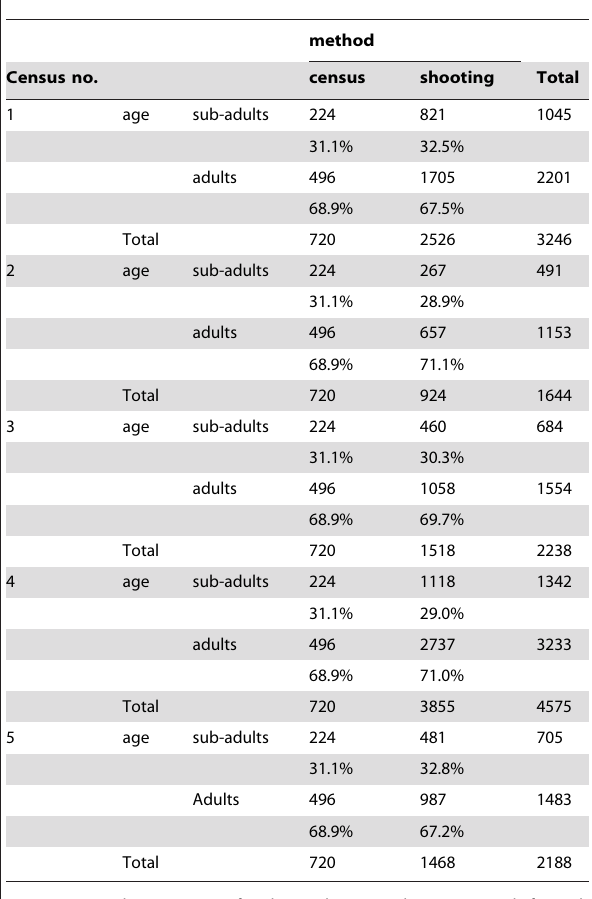
Table 2. Results of the exhaustive post-mortem examination of culled gulls (N =506 and 122 for shooting and caught by raptors